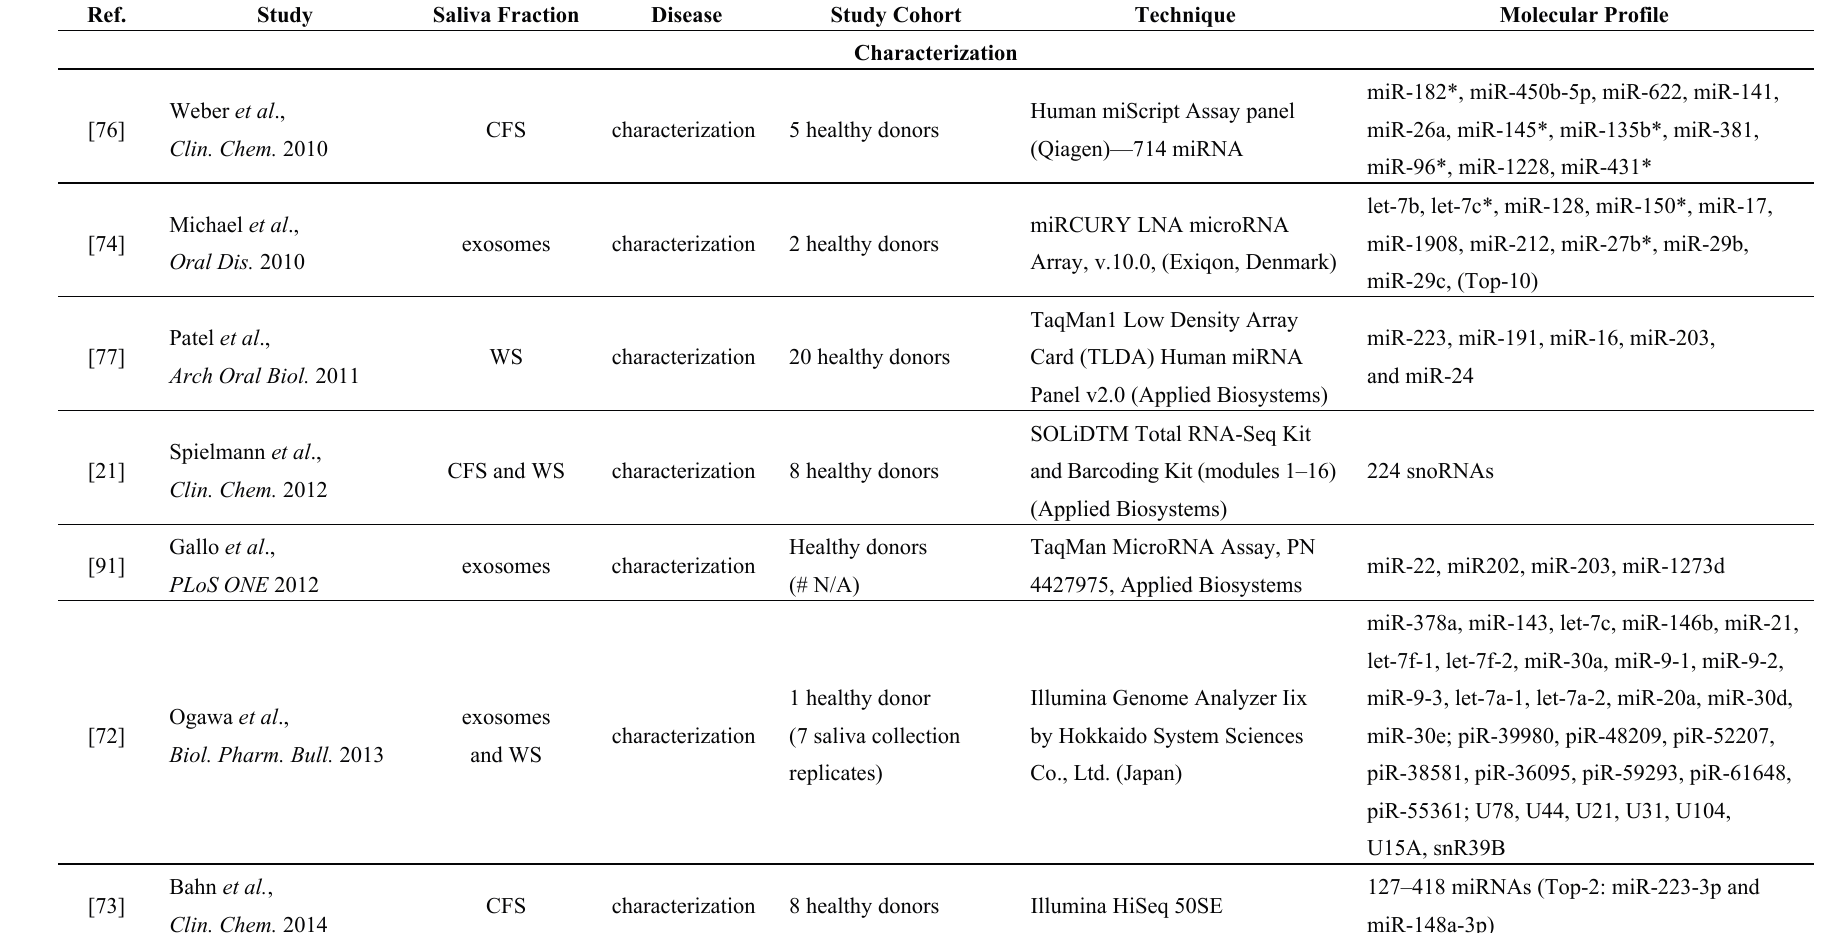
Table 1. Salivary ncRNAs as disease-related molecular